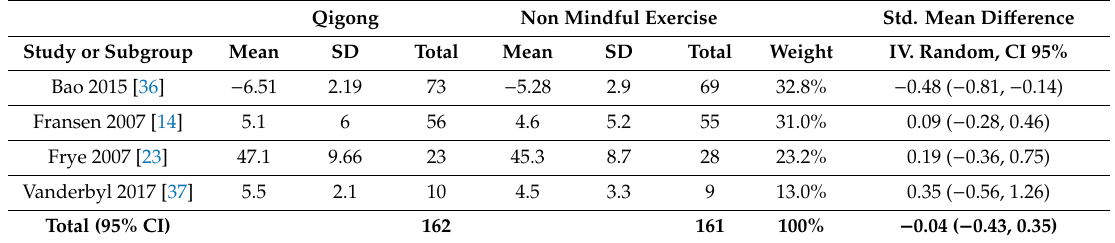
Figure 5. E ff ect of qigong on anxiety symptoms in comparison to non-mindful exercise. Figure 5. Effect of qigong on anxiety symptoms in comparison to non-mindful exercise. Table 4. E ff ect of qigong on anxiety symptoms in comparison to non-mindful